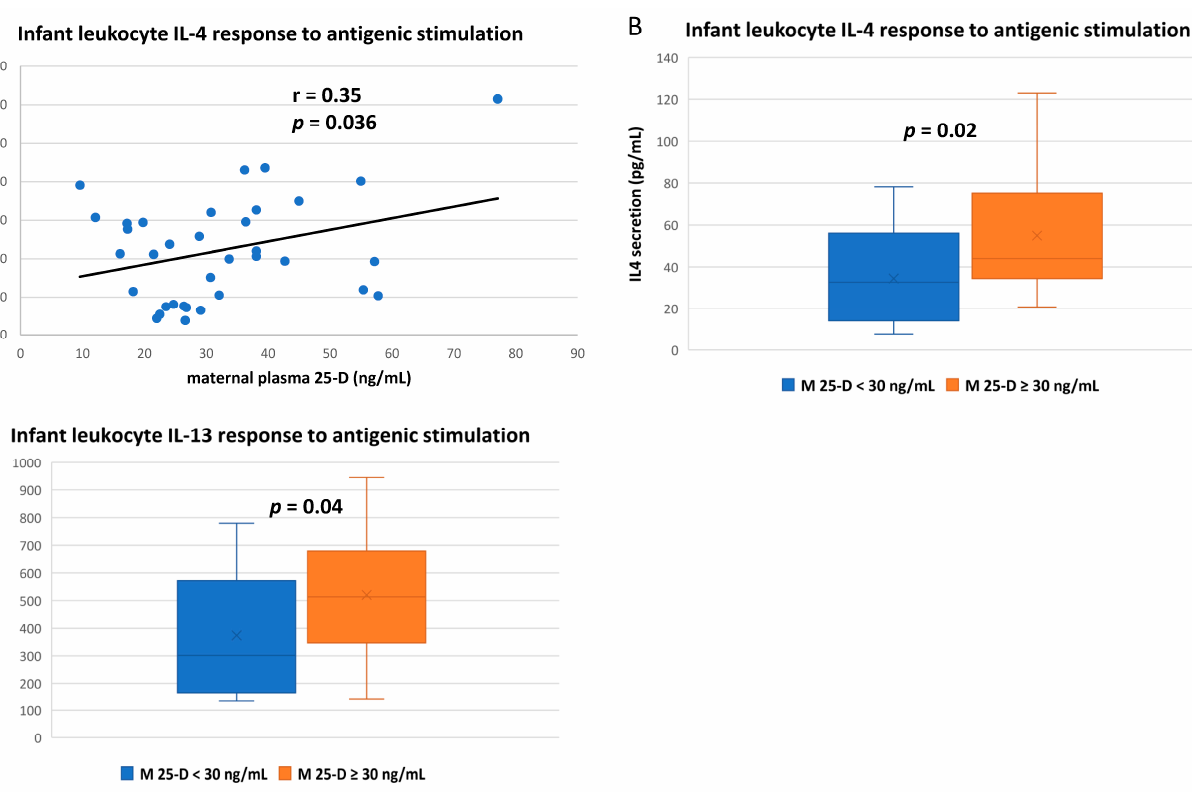
Figure 4. IL-4 and IL-13 responses of infant leukocytes to in vitro antigenic stimulation. Whole blood from breastfeeding infants was stimulated with an LPS-phorbol ester-ionomycin mixture for 20 h; culture supernatants were then collected for cytokine measurement by electrochemiluminescence. ( A ) Infant IL-4 release after stimulation correlated to maternal plasma 25-D (Pearson correlation). ( B ) Mean IL-4 and ( C ) IL-13 responses after antigenic stimulation compared between infants based on maternal vitD sufficiency (maternal plasma 25-D ≥ 30 ng/mL) at the corresponding time of blood draw (unpaired t